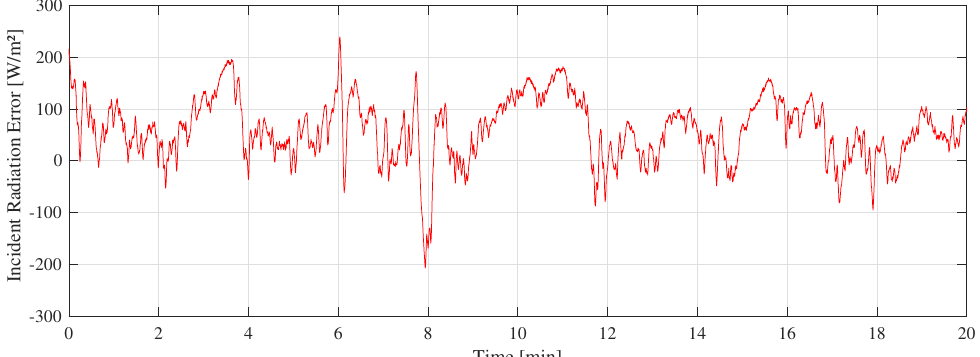
Figure 12. Difference between SR-05 and CTD prototype in A measurement.